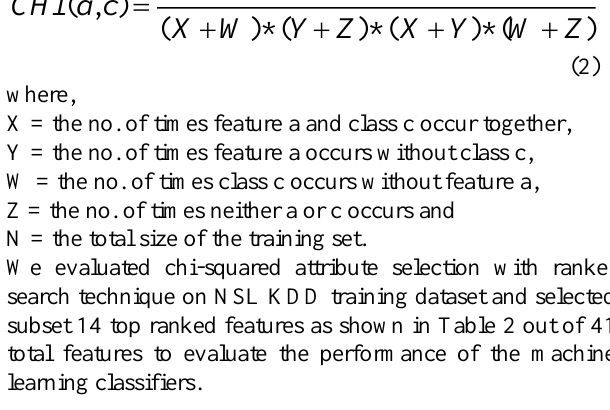
Table 2. Top 14 ranked features using